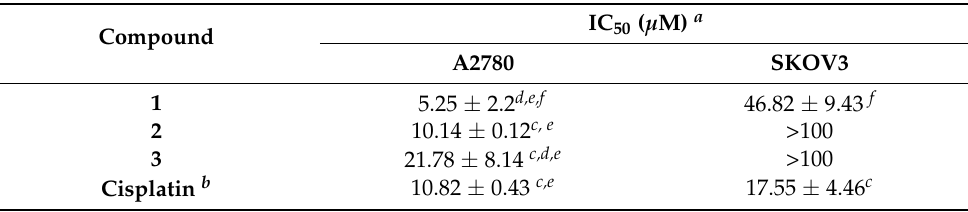
Table 3. The cytotoxicity of compounds 1 − 3 isolated from A. cochinchinensis in A2780 and SKOV3 human ovarian cancer